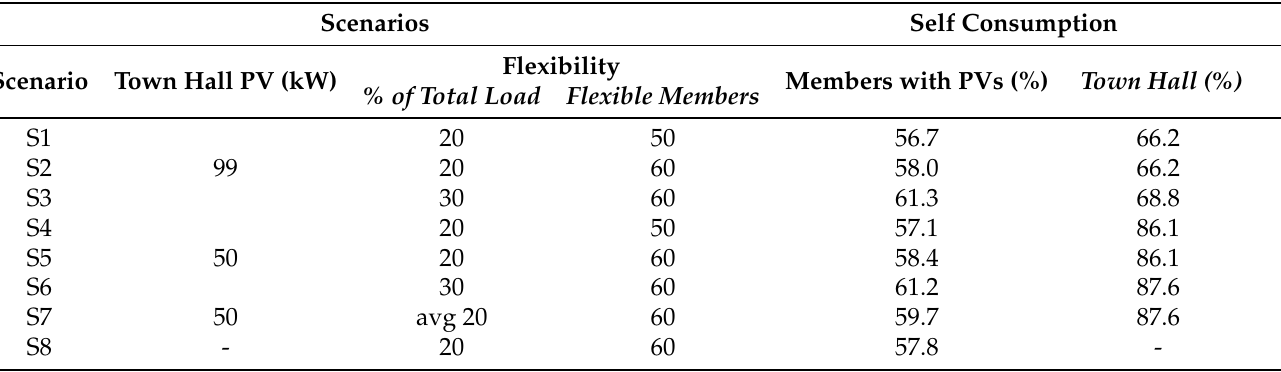
Table 5. Self-consumption for the PV